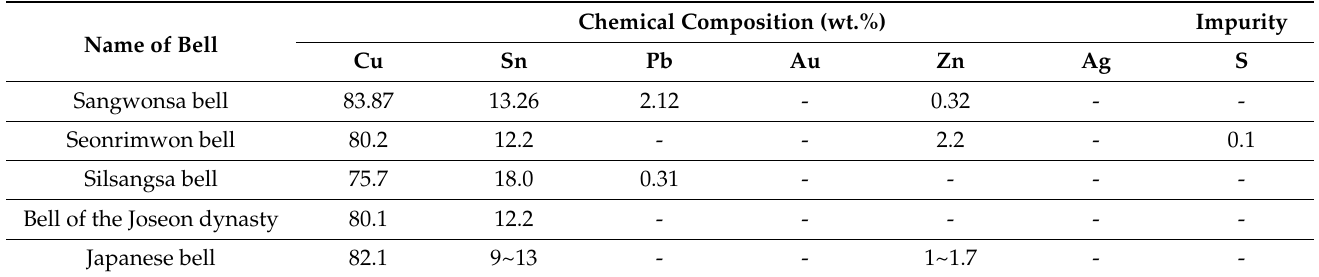
Table 2. Chemical composition of some temple bells surrounding the Korean Peninsula